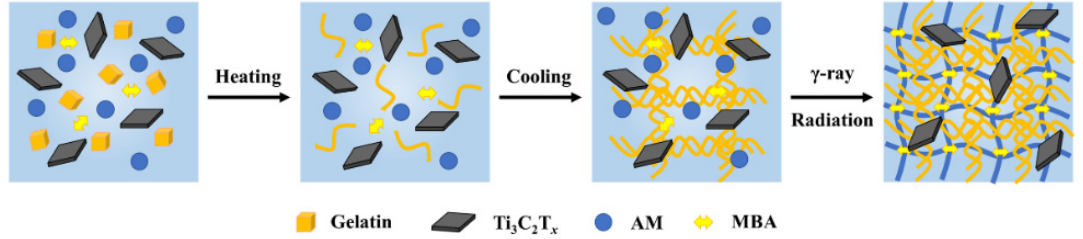
Figure 1. Schematic illustration of the synthesis and network structure of M/G/PAM NDN hydrogel. The compression and tensile tests were carried out to investigate the